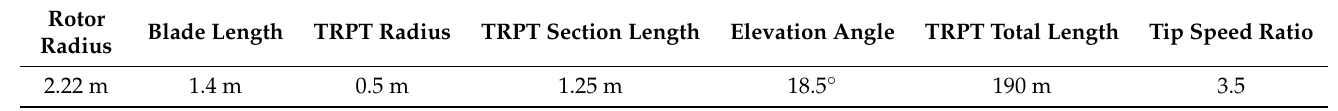
Table 4. Proposed Daisy Kite system